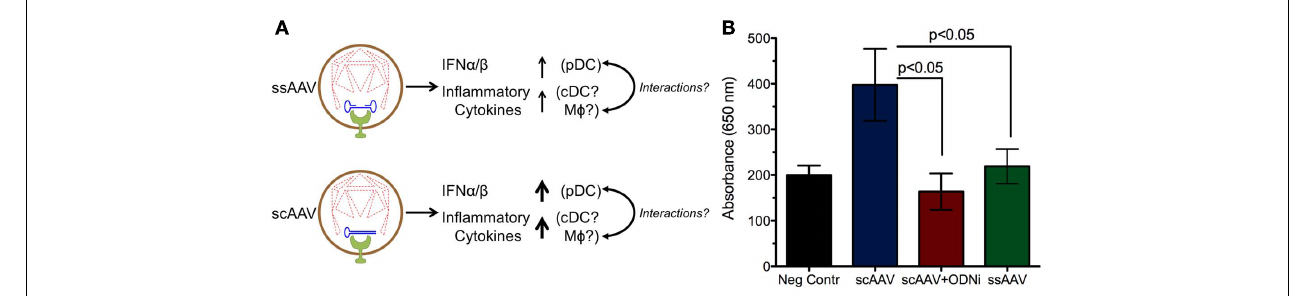
heightened inflammation relative to single-stranded DNA. (B) Experiments in aTLR9 reporter cell line demonstrate that sensing of scAAV results in stronger TLR9 signaling compared to ssAAV; this response can be blocked byTLR9 antagonists. Secreted embryonic alkaline phosphatase (SEAP) levels were measured by absorbance at 650nm followingTLR9 activation in a 293 reporter cell line (Invivogen, San Diego, CA, USA) after infection at an MOI of 10 4 with ssAAV, scAAV, or scAAV with aTLR9 inhibitory oligonucleotide